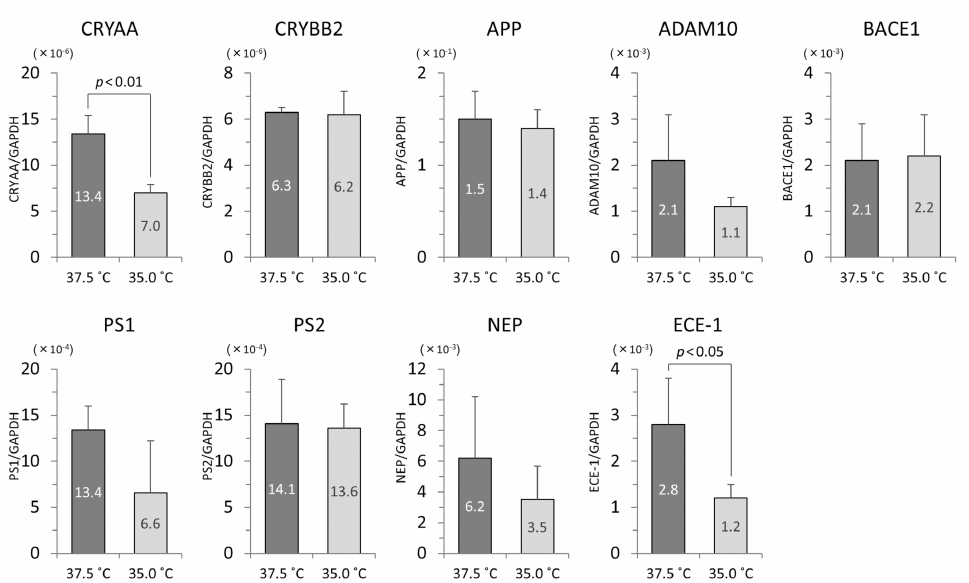
Figure 7. The qPCR results related to lens protein and A β protein in SRA01 / 04 cells. The vertical axis is the mRNA value of the target gene-corrected by GAPDH.